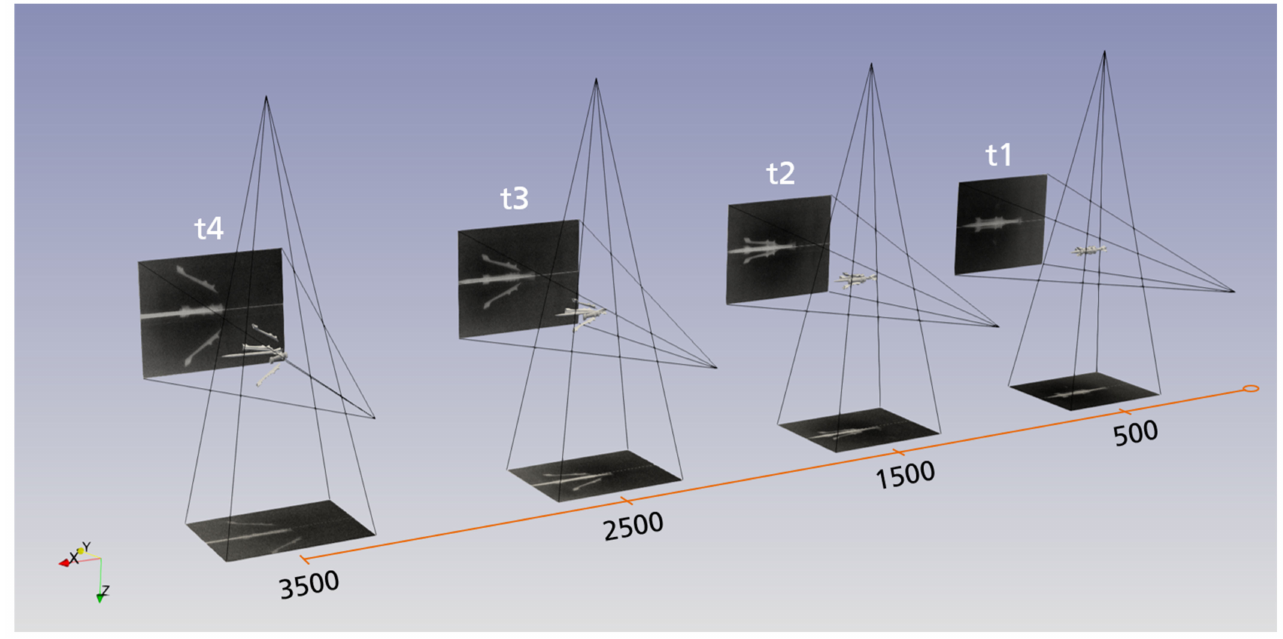
Figure 4. Illustration of the results of the evaluation software. The projectile, the sabot parts, the X-ray tubes and image plates are located and orientated in space in a single coordinate system. The firing axis is chosen as the x -axis, the y -axis is the horizontal and the z -axis is the vertical